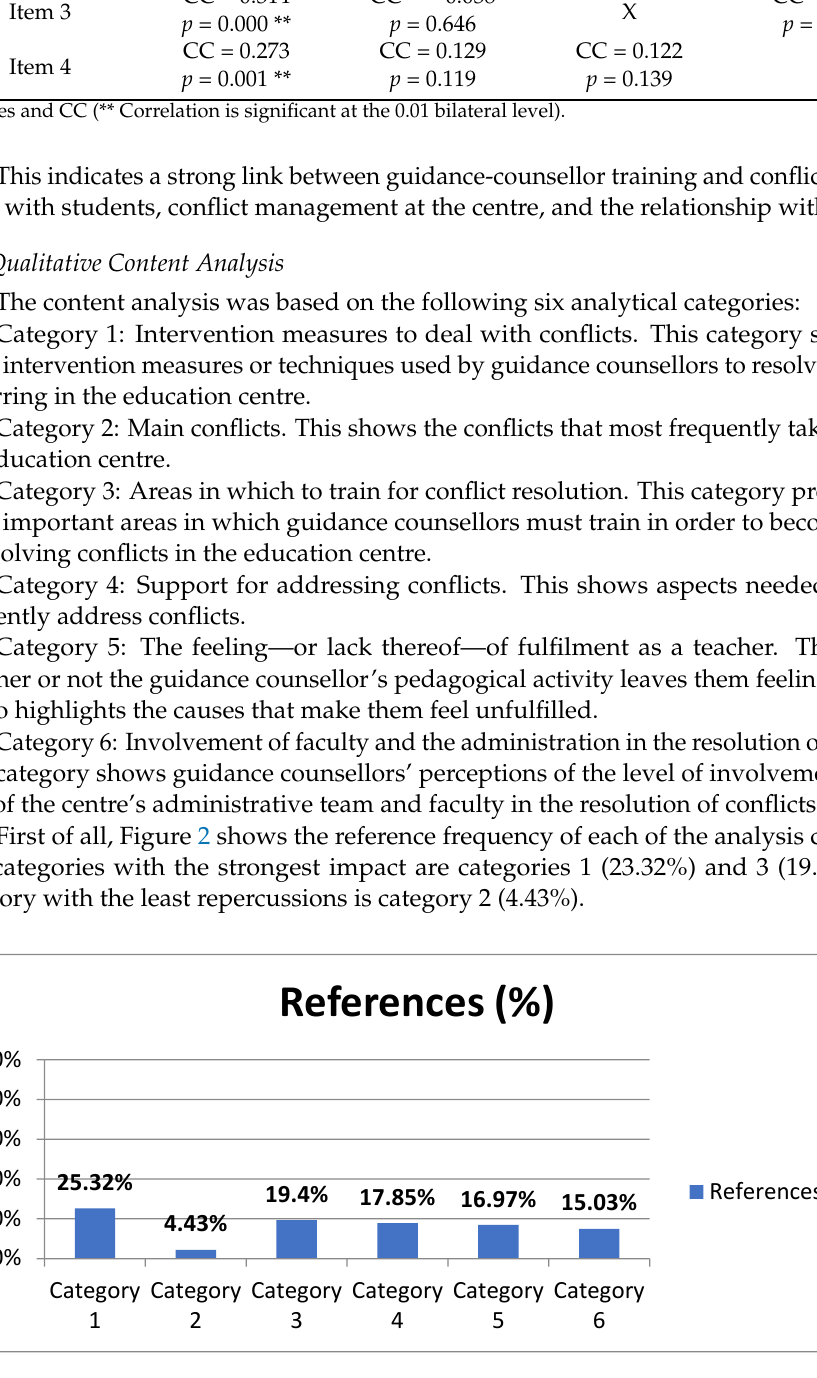
Figure 2. Reference frequency of analysis categories.